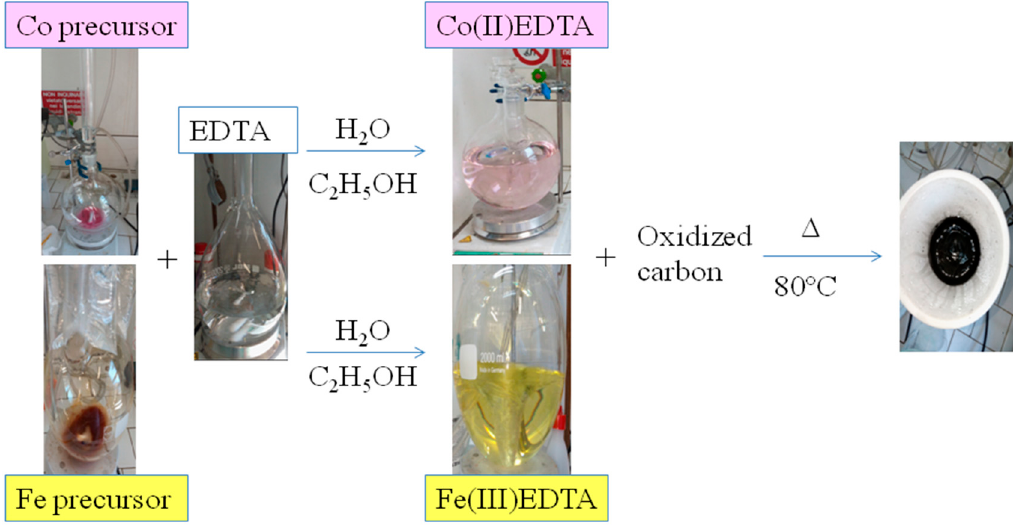
Figure 1. Representation of synthesis procedure for Co-ethylene diamine tetra acetic acid (EDTA) and Fe-EDTA.